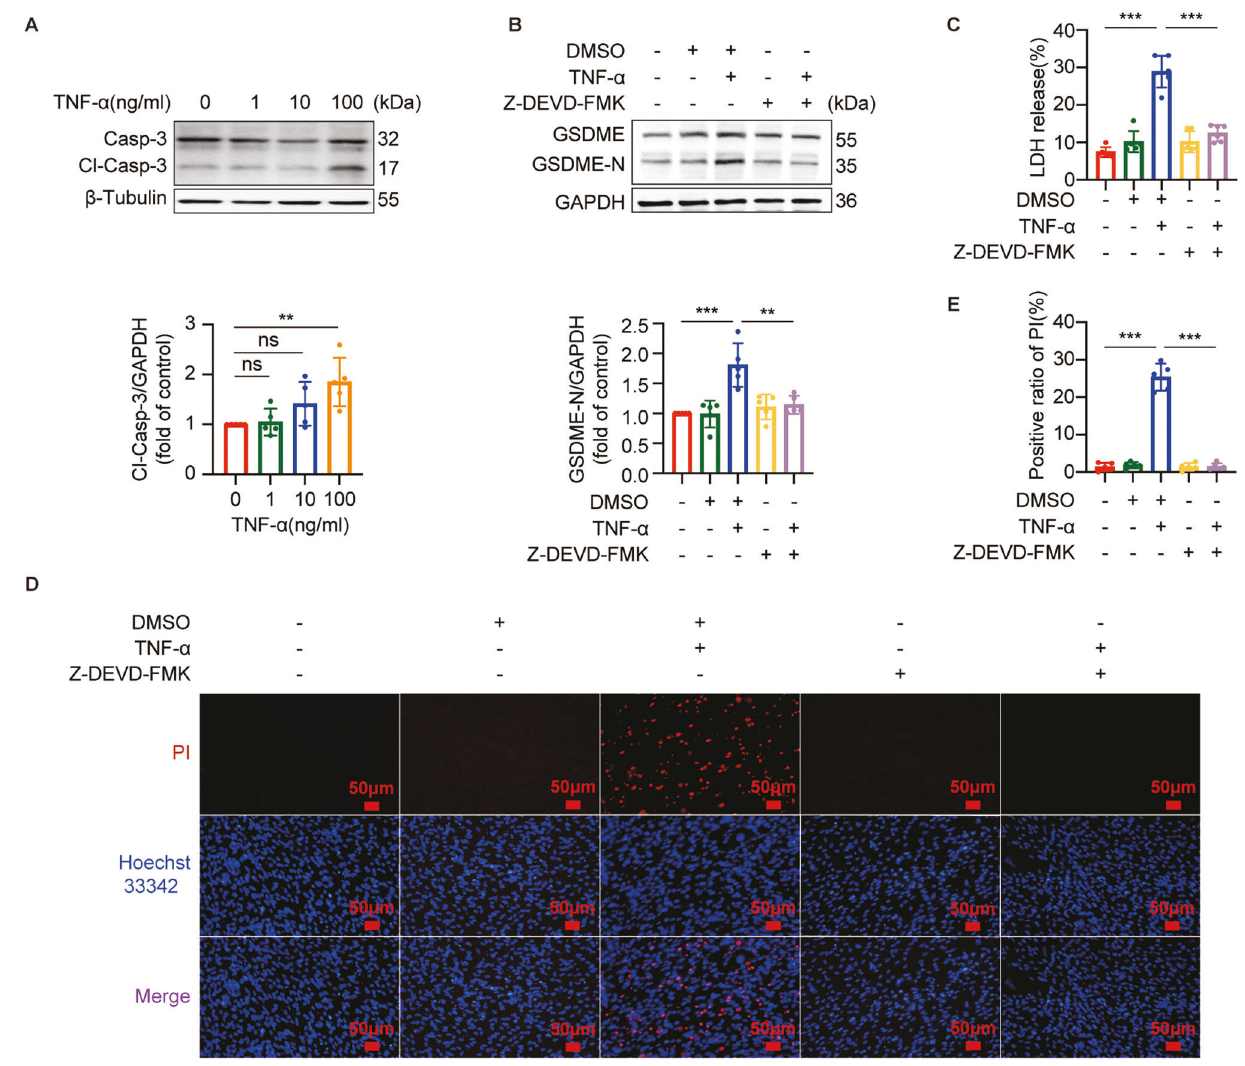
Fig. 5 Activation of Casp-3 was required for TNF- α -induced pyroptosis in C2C12 myotubes. A immunoblots of Casp-3 and Cl-Casp-3 in myotubes treated with different concentrations (0, 1, 10, or 100 ng/ml) of TNF- α for 72 h. Relative expression levels of Cl-Casp-3 normalized to β -Tubulin based on densitometric analysis of immunoblots. B – E myotubes were pretreated with Z-DEVD-FMK (50 μ M) for 1 h followed by treatment with TNF- α (100 ng/ml) for 72 h. The expressions of GSDME and GSDME-N in myotubes were immunoblotted and analyzed based on densitometric analysis of immunoblots ( B ). Cell death was determined by measuring LDH release into the cell culture supernatant ( C ) and staining with Hoechst 33342/PI ( D ) after myotubes treatments. Scale bar: 50 μ m. E Quantitation of positive ratio of PI. Data are expressed as mean ± SD. ** P < 0.01, *** P < 0.001, ns: no signi fi cance. n = 5 independent